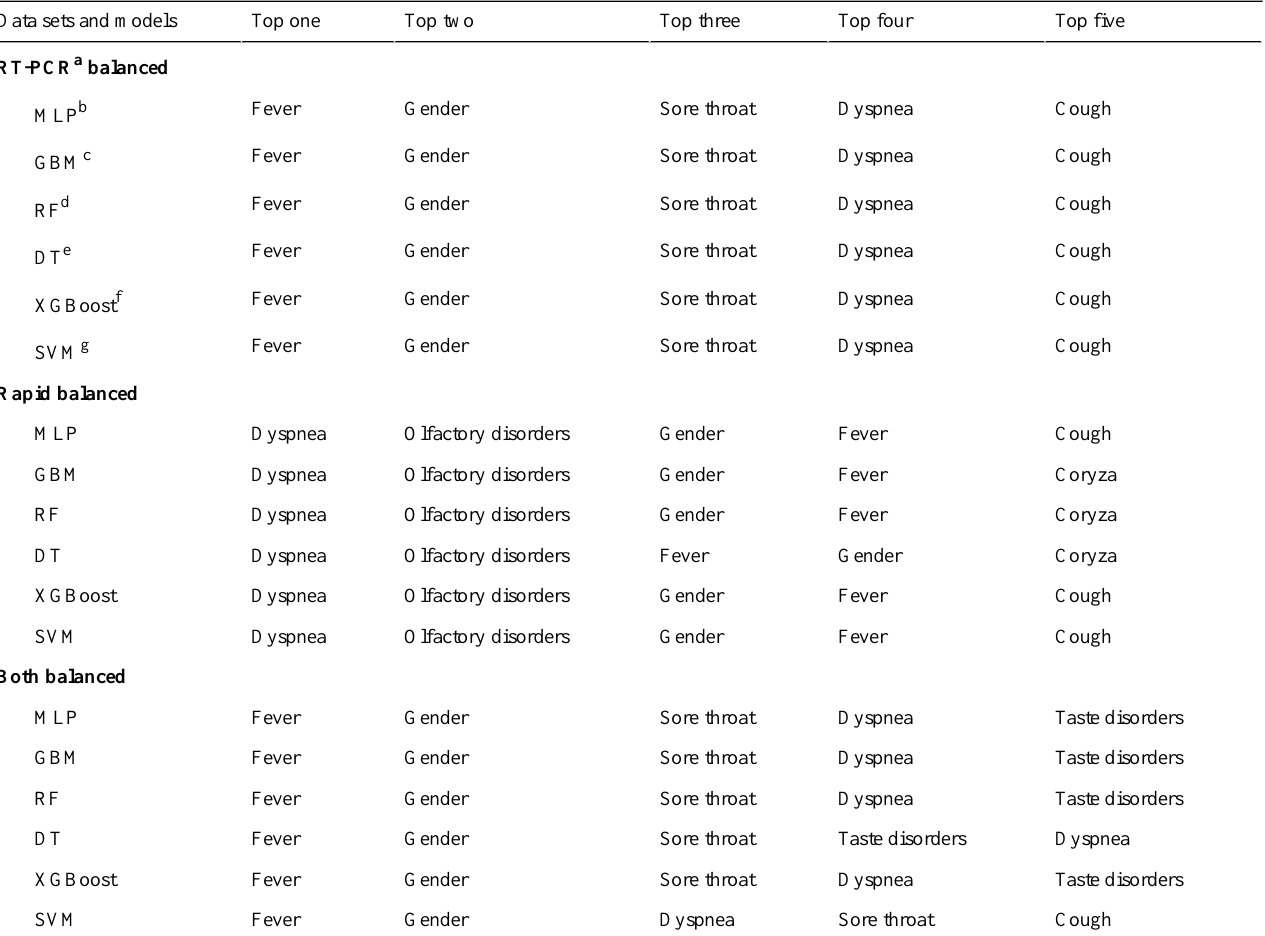
Table 5. The five most significant factors for COVID-19 test prioritization using the classification models with the highest performances and the data